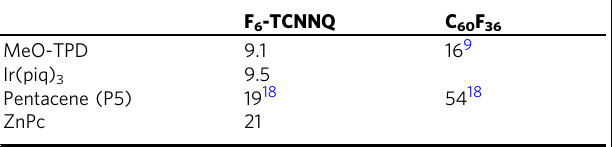
Fig. 3c, showing C d ( f,T ) spectra for ZnPc:F 6 -TCNNQ. Below 150 free carriers provided by doping is not suf fi cient to fi ll the (deep) traps anymore 10 . For T < 100 K, the trap response itself vanishes ( f < 100 Hz) 18 and at 20 K the C d ( f ) curve is fl at. The Schottky